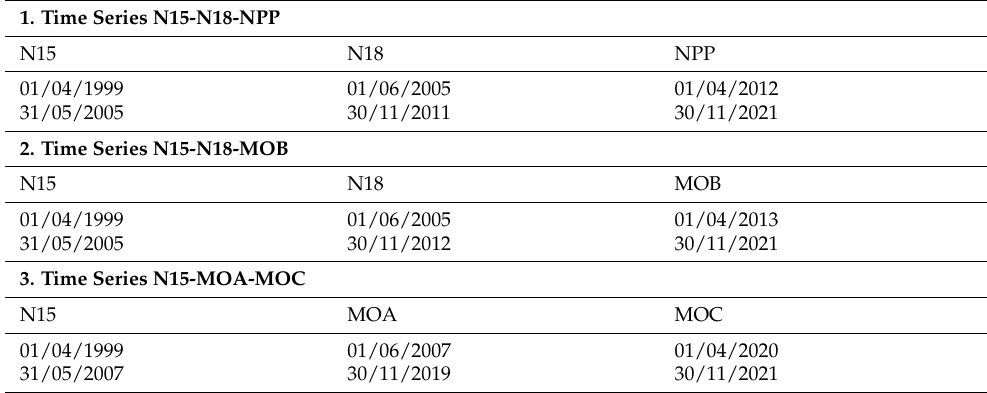
Table 2. Composition of the analyzed time series of annual number of H or SH events.